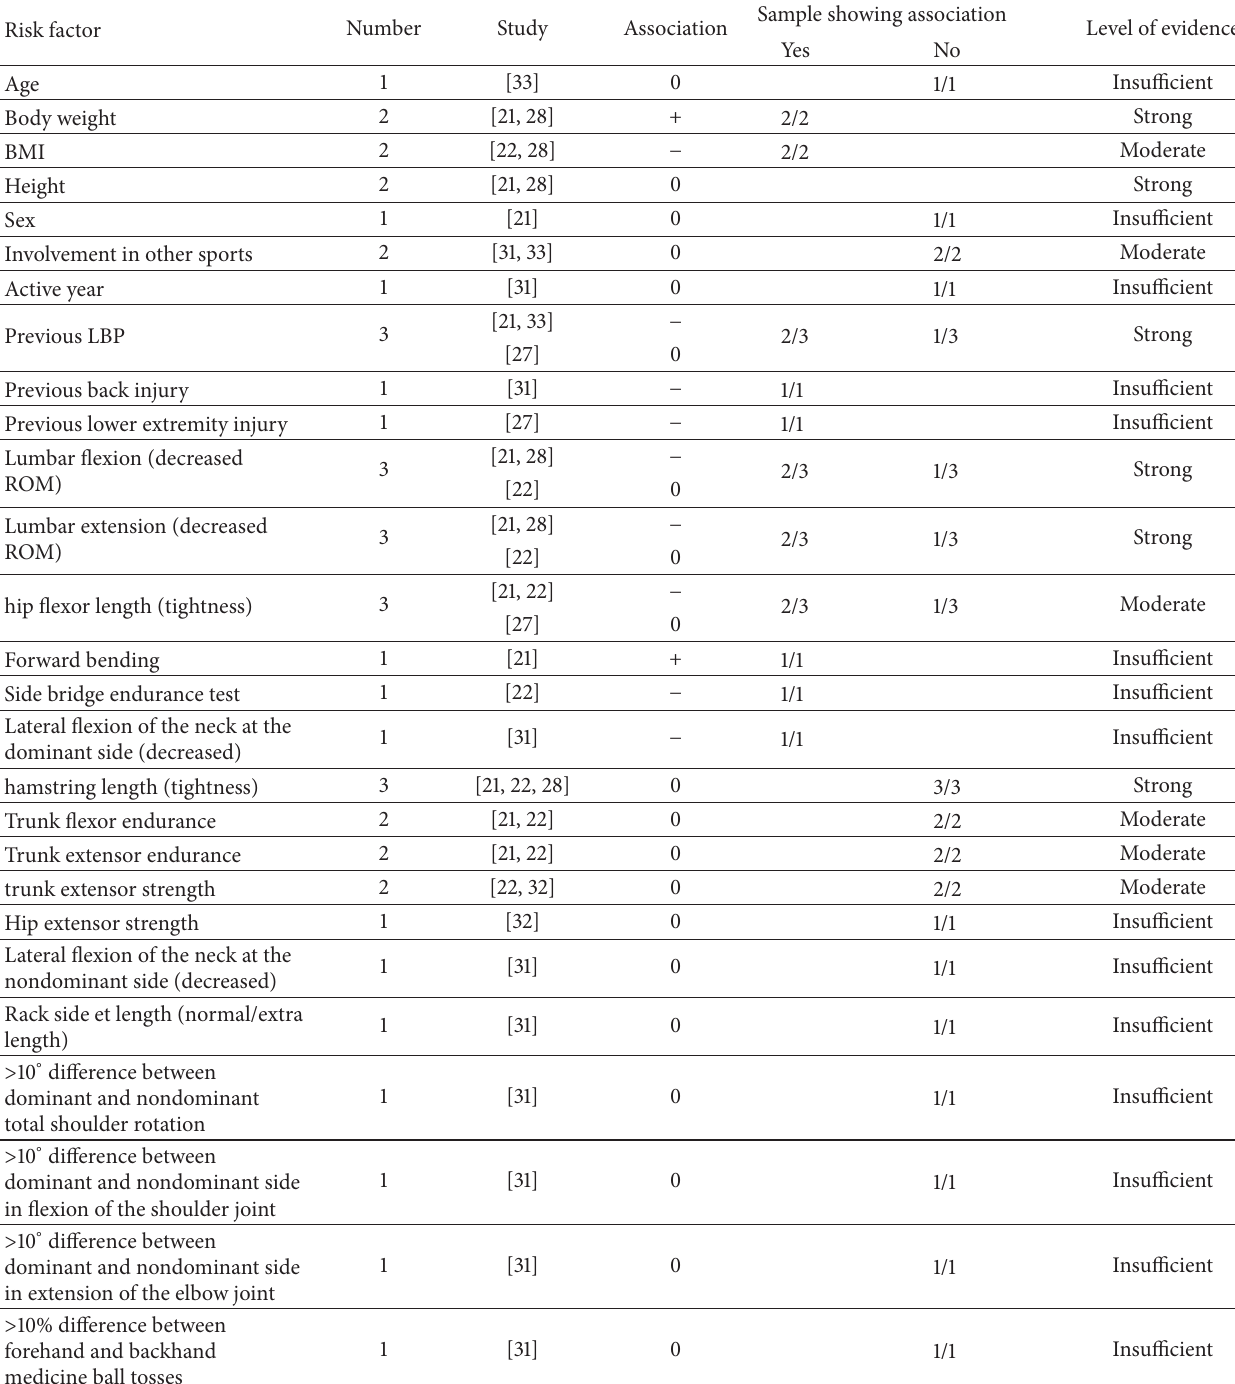
Table 4: The results of prospective studies on risk factors of low back pain in